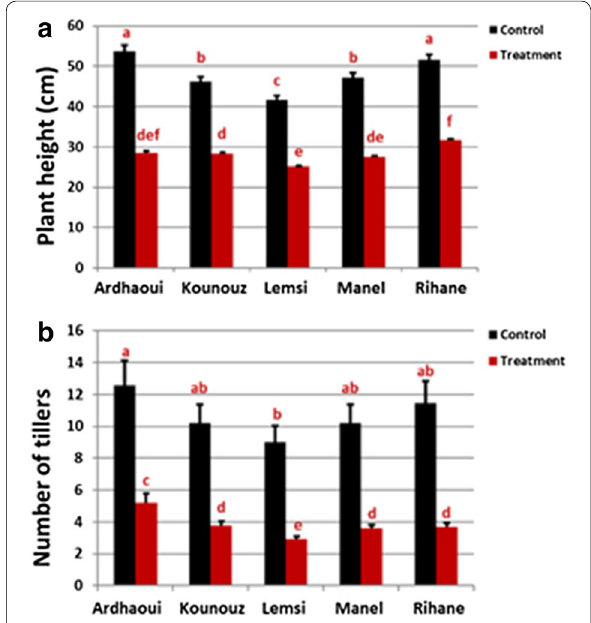
Fig. 2 Plant height ( a ) and number of tillers ( b ) for the five barley genotypes under control and salinity treatment conditions. Significant differences among the genotypes, treatments and the interaction showed with the red letters and has been calculated using R 3.5.3 ( P value < 0.05) (color figure